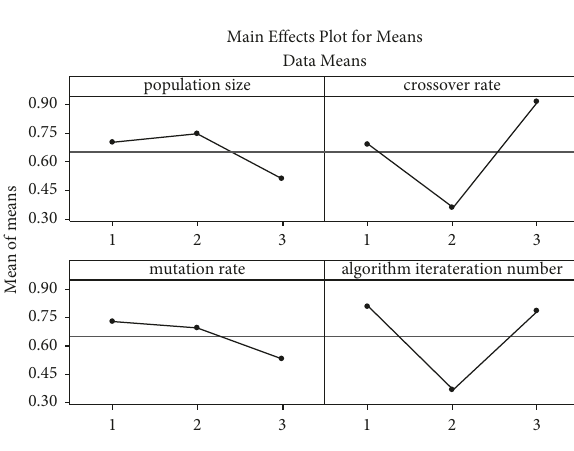
Figure 8: The mean effect of GA.